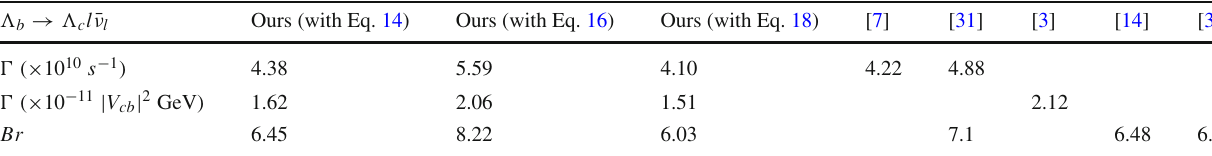
Table 3 Comparison of theoretical predictions for the (cid:2) b semileptonic decay parameters (cid:2) → (cid:2) ¯ ν b c l l Ours (with Eq. 14) Ours (with Eq. 16) Ours (with Eq. 18)